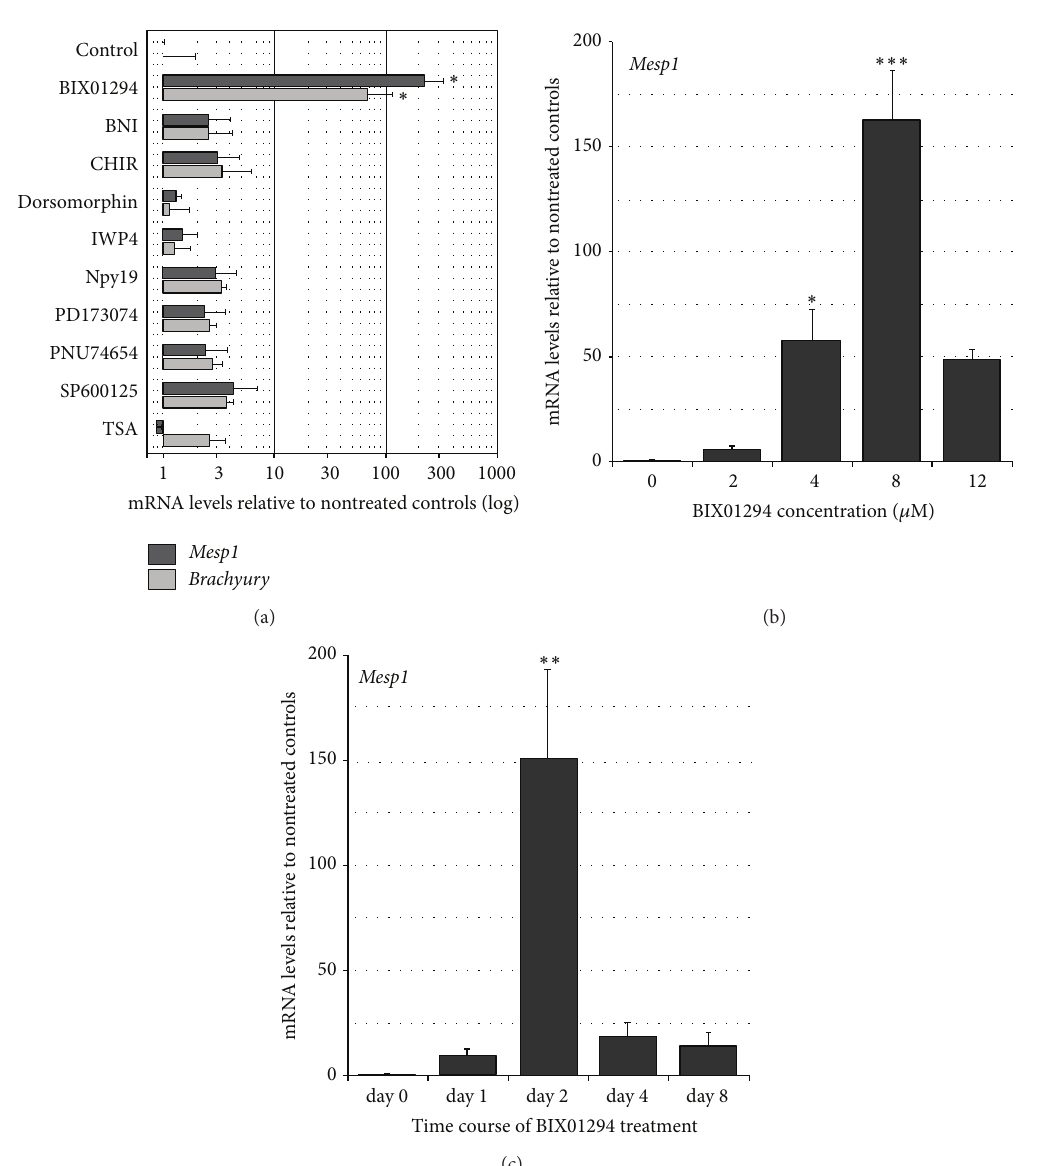
Figure 2: MSCs express precardiac markers in response to BIX01294. (a) MSCs were exposed to multiple compounds over a range of concentrations, with RNA harvested and analyzed by qPCR. Chart summarizes results with optimized doses of inhibitors specific for G9a HMTase(BIX01294),nitricoxidesynthase(3-bromo-7-nitroindazole;BNI),GSK3 𝛽 (CHIR99021),BMP(dorsomorphin),Wnt(IWP4),TGF 𝛽 (1,5-naphthyridine pyrazole derivative-19; NPy19), FGF (PD173074), 𝛽 -catenin (PNU74654) c-Jun N-terminal kinase (SP600125), and histone deacetylase (trichostatin A; TSA). Only BIX01294 was able to significantly enhance Mesp1 and brachyury expression over control levels. Note that the relative levels of gene expression are shown in log scale. (b) Parallel cultures of MSCs treated for 48 hrs with various concentrations of BIX01294 and assayed for Mesp1 gene expression using real-time qPCR. MSCs exhibited the highest levels of Mesp1 expression when exposed to 8 𝜇 M BIX01294. (c) MSCs exposed to 8 𝜇 M BIX01294 for up to 8 days and examined for Mesp1 gene expression, with optimal responses obtained at 48-hour incubation. ∗∗∗ 𝑝 < 0.001 ; ∗∗ 𝑝 < 0.005 ; ∗ 𝑝 < 0.01